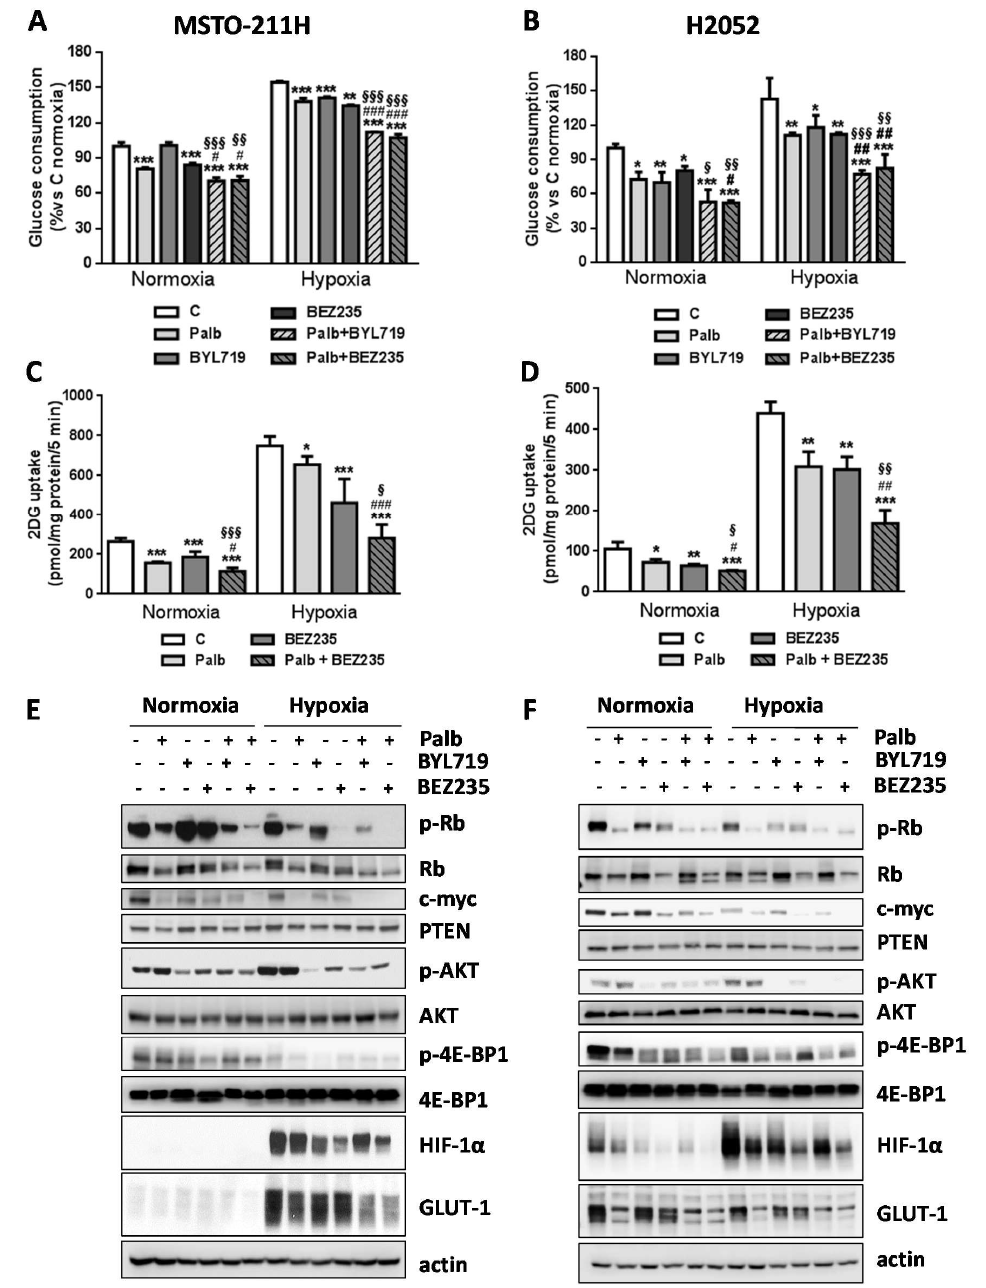
Figure 5. The combined treatment of palbociclib with PI3K/mTOR inhibitors hinders energy metabolism by down-regulating Rb/E2F/ c -myc and PI3K/AKT/mTOR signaling in MSTO-211H and H2052 MPM cells. ( A , B ) Cells were treated with palbociclib 1 μM, BEZ235 40 nM, BYL719 (1 μM for MSTO-211H cells or 2.5 μM for H2052 cells) or the combination of palbociclib with BEZ235 or BYL719 for 24 hunder normoxic or hypoxic (1% O 2 ) conditions for 24 h. At the end of the treatments, glucose consumption was measured. * p < 0.05,** p < 0.01,*** p < 0.001 vs. C normoxia; # p < 0.05, ## p < 0.01, ### p < 0.001 vs. palbociclib; § p < 0.05, §§ p < 0.01, §§§ p < 0.001 vs. BEZ235 or BYL719. ( C , D ) Cells were treated with palbociclib 1 μM or BEZ235 40 nM alone or in combination under normoxic or hypoxic (1% O 2 ) conditions for 24 h. At the end of the treatment, glucose uptake was measured. * p < 0.05, ** p < 0.01, *** p < 0.001 vs. C; # p < 0.05, ## p < 0.01, ### p < 0.01 vs. palbociclib; § p < 0.05, §§ p < 0.01, §§§ p < 0.01 vs. BEZ235. MSTO-211H ( E ) and H2052 ( F ) cells were treated as in ( A , B ), then Western